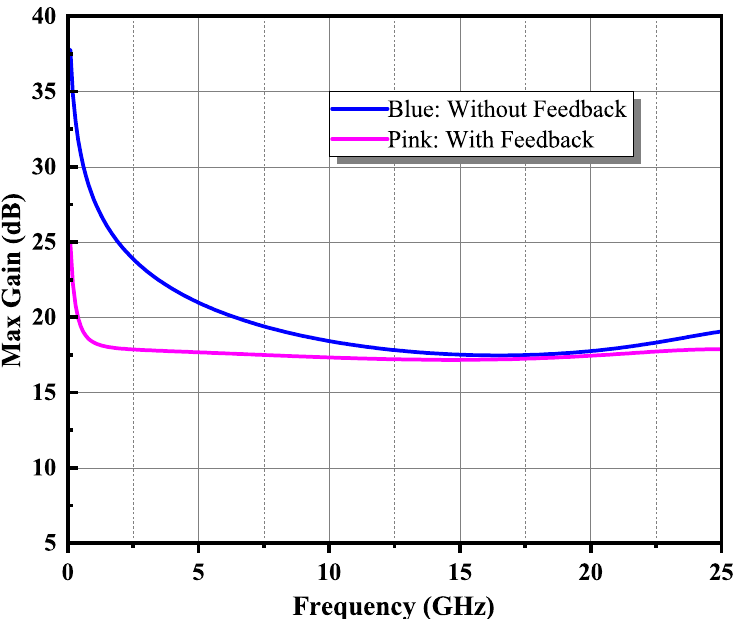
Figure 2. Simulated maximum gain of the first stage with and without enhanced feedback